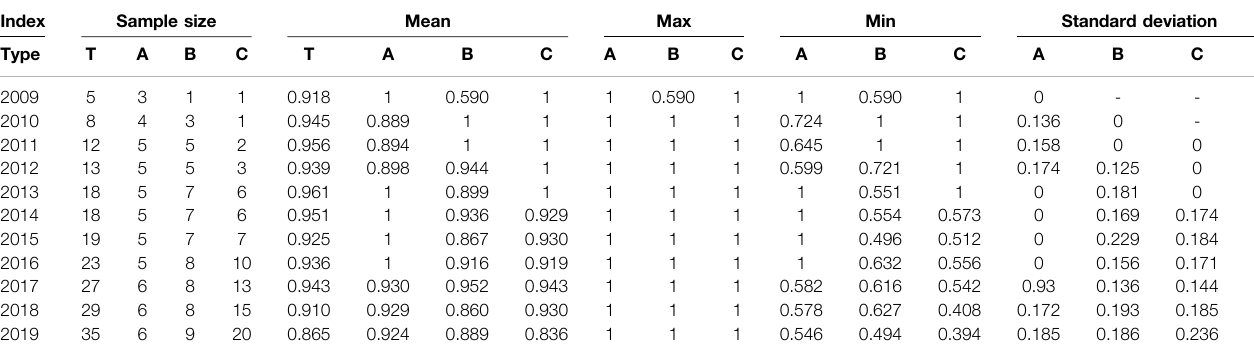
TABLE 7 | Descriptive Statistics of vrs green credit ef fi ciency from 2009 to